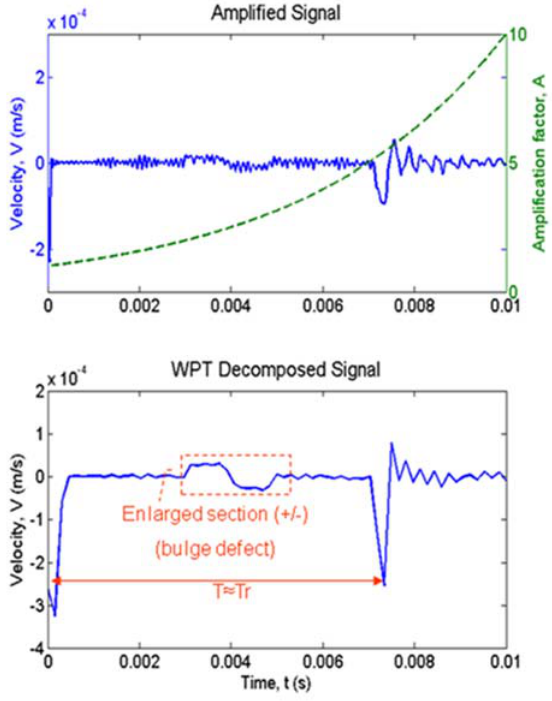
Figure 16. Amplified and WPT decomposed velocity signal for case e of dataset 5 (bulge imperfection).